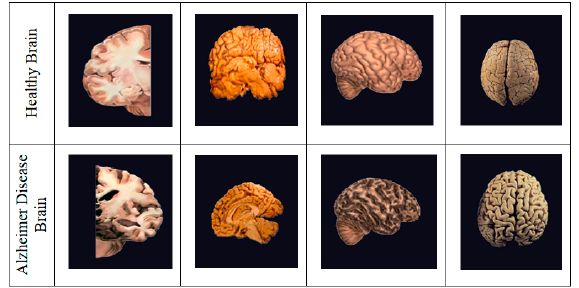
Figure 1. Healthy Brain vs. Alzheimer’s Diseased Brain. Compared to a healthy brain, the Alzheimer’s drain can be noted with shrinkage in size, less moisture, and enlarged ventricles.